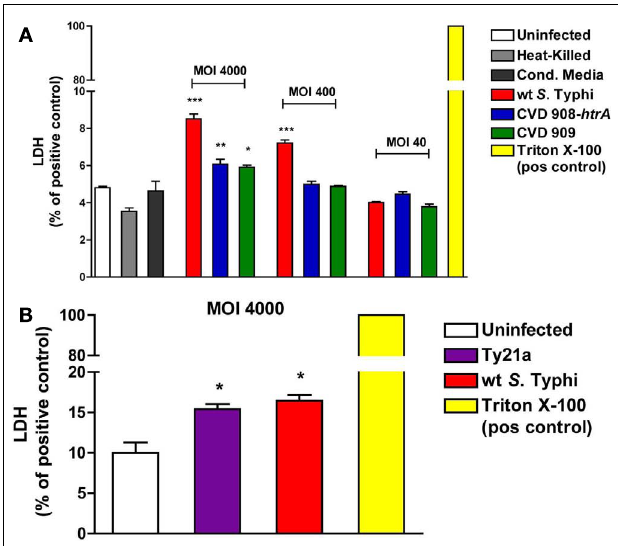
FIGURE 3 | Effect of S .Typhi infection on cell viability. LDH levels were measured in the apical media as an index of cell death.Values represent LDH release as a percentage of total LDH (positive control,Triton X-100). (A) LDH levels after infection with wild-type S .Typhi and its aro mutants at different MOI’s. (B) LDH release after infection with wild-type S .Typhi and Ty21a applied at a MOI of 4000:1. Data are expressed as means ± SEM for triplicate samples for all conditions tested.These results are representative of three experiments with similar results. *** p < 0.001, ** p < 0.01, * p < 0.05 compared to uninfected cells (ANOVA).